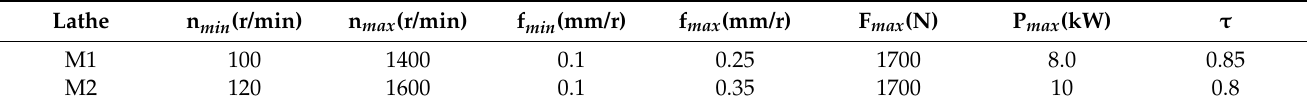
Table 2. Tool parameters.